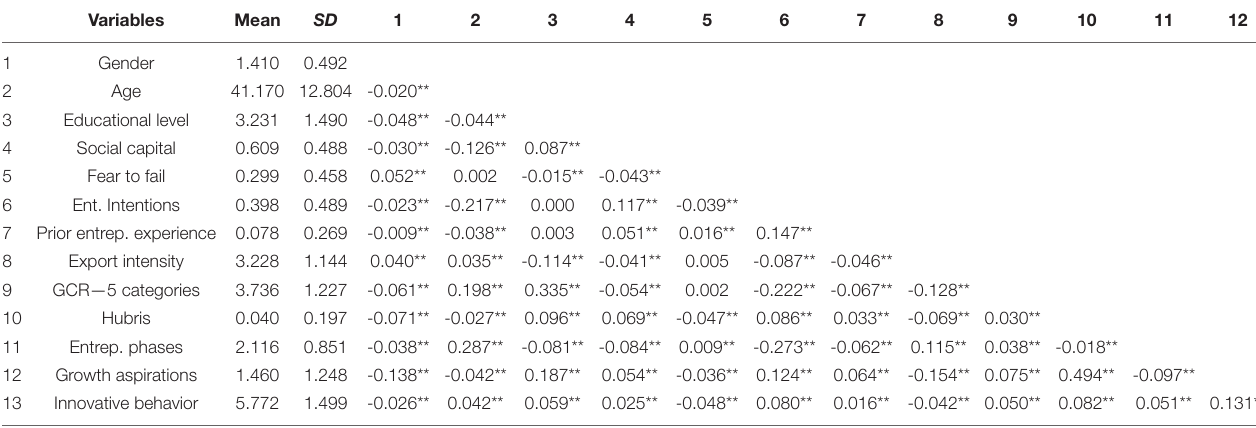
TABLE 2 | Mean, standard deviation, and correlations.